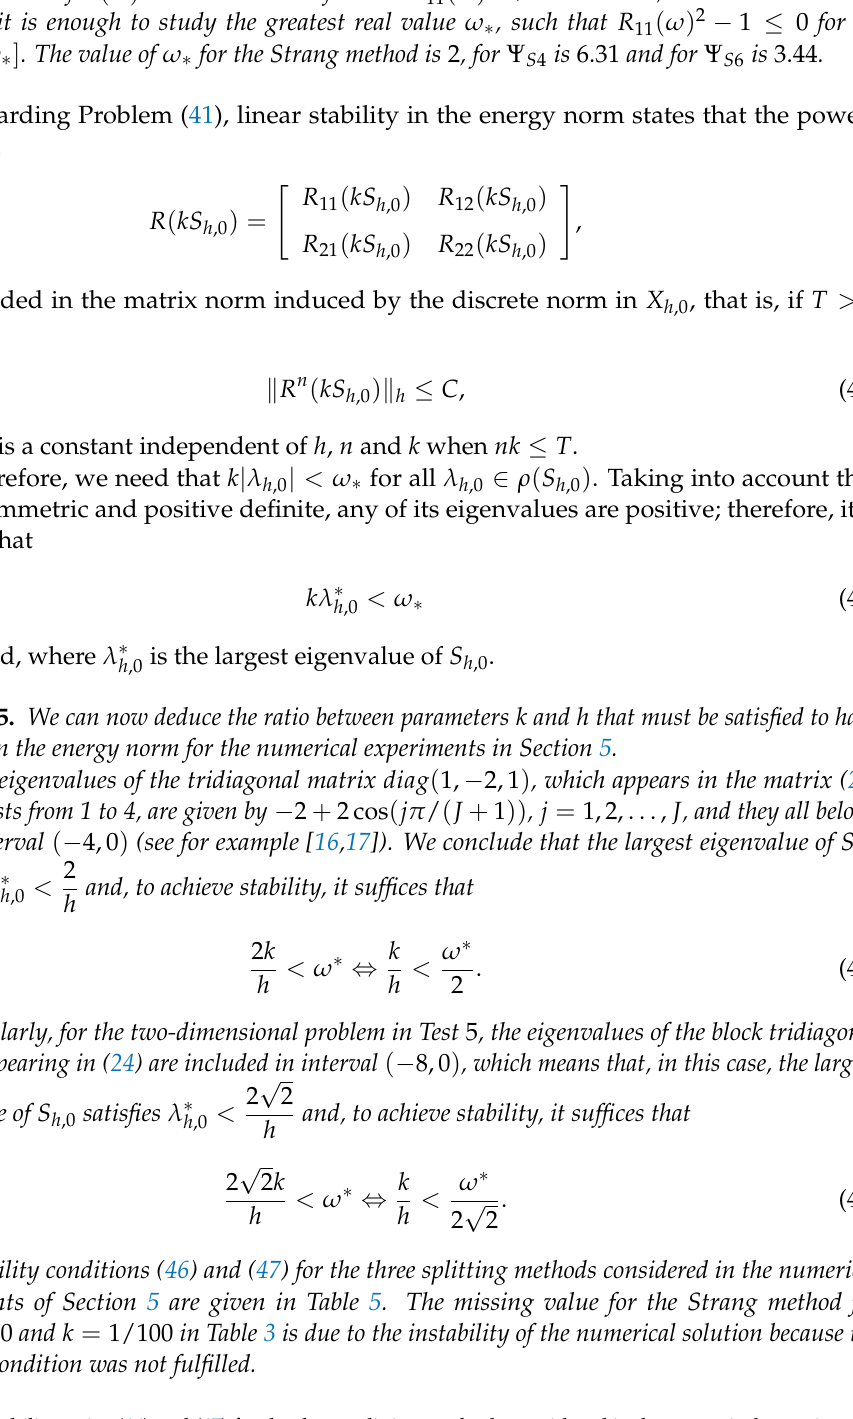
Table 5. Stability ratios (46) and (47) for the three splitting methods considered in the numerical